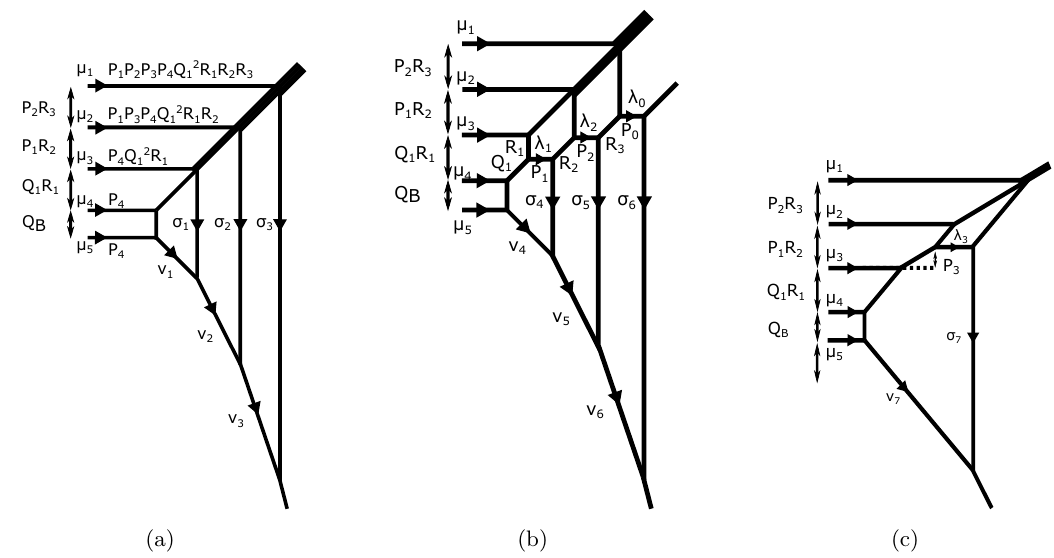
Figure 41. Parametrization of the web diagram for the geometry e (1)